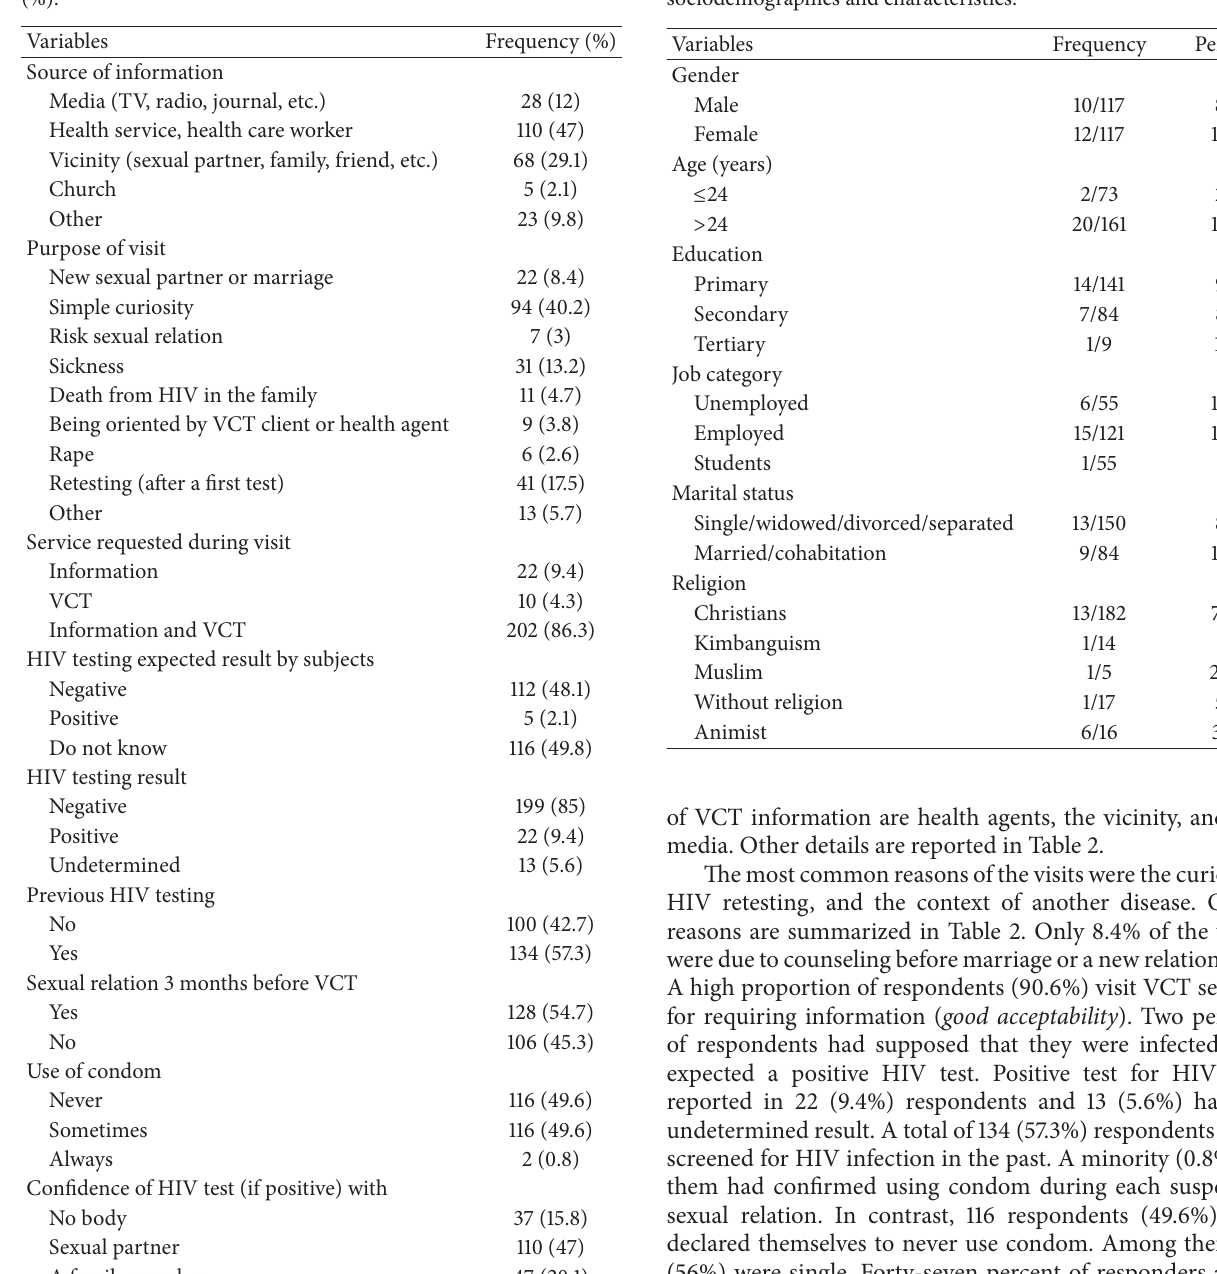
Table 2: Knowledge, attitude, and behavioral variables frequency (%).